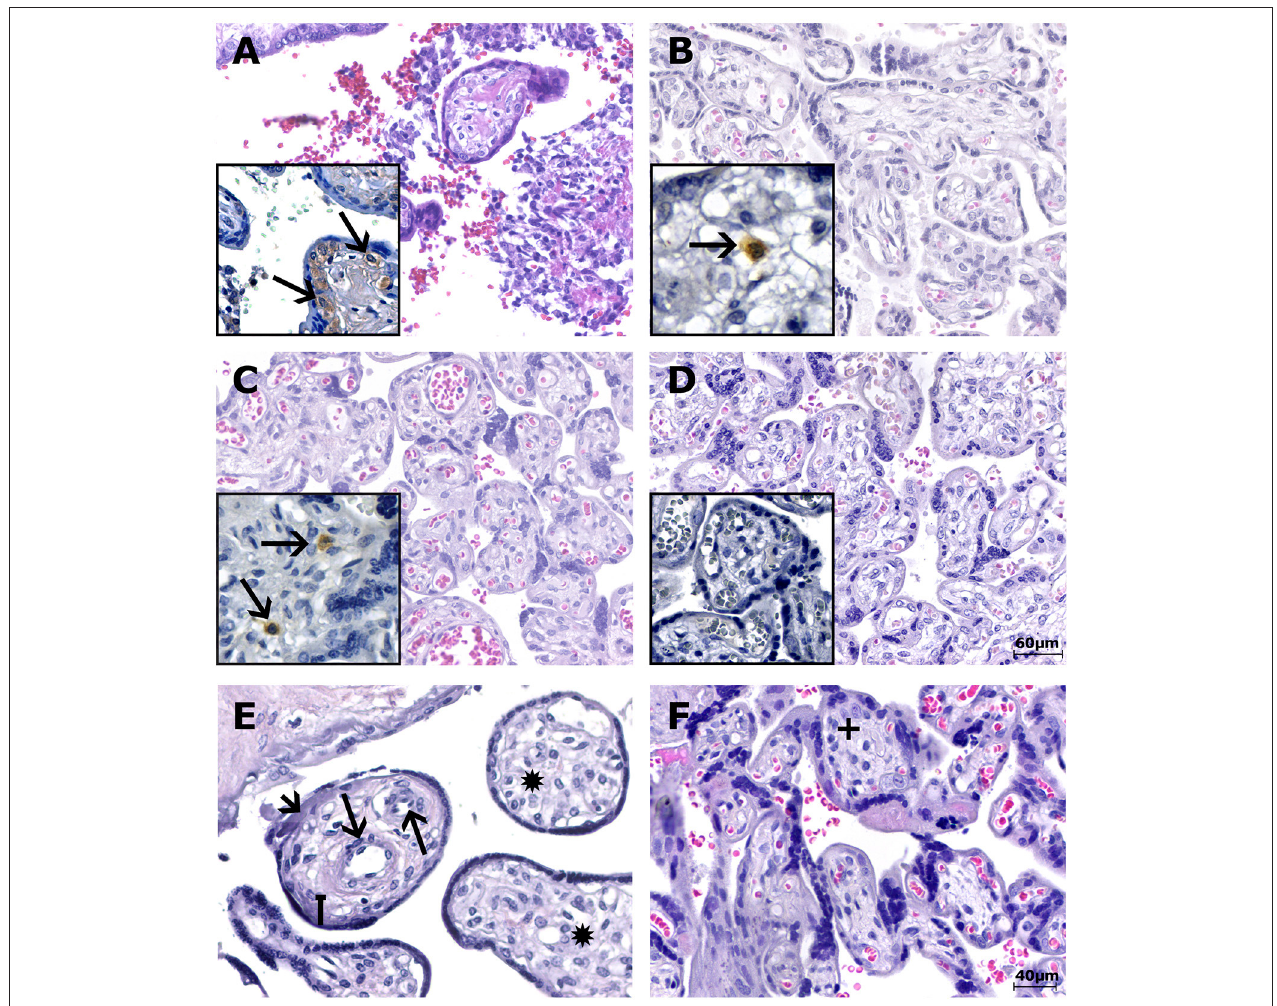
FIGURE 1 | Photomicrography of the placental samples stained with H&E or immunostained with anti-ZIKV MAb and stained with Harris’s hematoxylin (squares). The scale bars are 60 µ m (A–D) and 40 µ m (E,F) . (A) Case LRV/15 572—First trimester placenta sample (chorion frondosum) showing chronic villitis (TORCH-like) with lymphohistiocytic chronic villous inflammation. (B) Case LRV/16 515—Third trimester placenta sample (chorion frondosum) showing delayed villous maturation with additional stromal changes, such as stromal fibrosis. (C) Case LRV/16 845—Third trimester placenta sample (chorion frondosum) showing delayed villous maturation with persistence of the cytotrophoblastic layer, stromal fibrosis and reduced numbers of syncytial knots. (A–C) The squares highlight Hofbauer cells positive for anti-ZIKV MAb (arrows) inside the chorionic villi. Notice that the cytotrophoblast and syncytiotrophoblast cells, as well as other fibroblastic cells inside Wharton’s jelly, are negative for anti-ZIKV MAb. (D) Negative control (ZIKV-negative patient)—Third trimester placenta sample (chorion frondosum) without pathological changes. Hofbauer cells are negative for anti-ZIKV MAb inside the chorionic villi (square). Note that the cytotrophoblast and syncytiotrophoblast cells, as well as other fibroblastic cells inside Wharton’s jelly, are negative for the antibody used. (E) Case LRV/15 578—Third trimester placenta sample (chorion frondosum) showing delayed villous maturation with additional stromal changes, such as stromal fibrosis (square arrow), an increase in the number of fetal capillaries (arrows), hyperplasia of Hofbauer cells (*) and an increase in intravillous fibrinoid deposits (arrow head). (F) Negative control (ZIKV-negative patient)—Third trimester placenta sample (chorion frondosum) showing a normal number of Hofbauer cells ( + ). No delayed villous maturation or additional stromal changes were